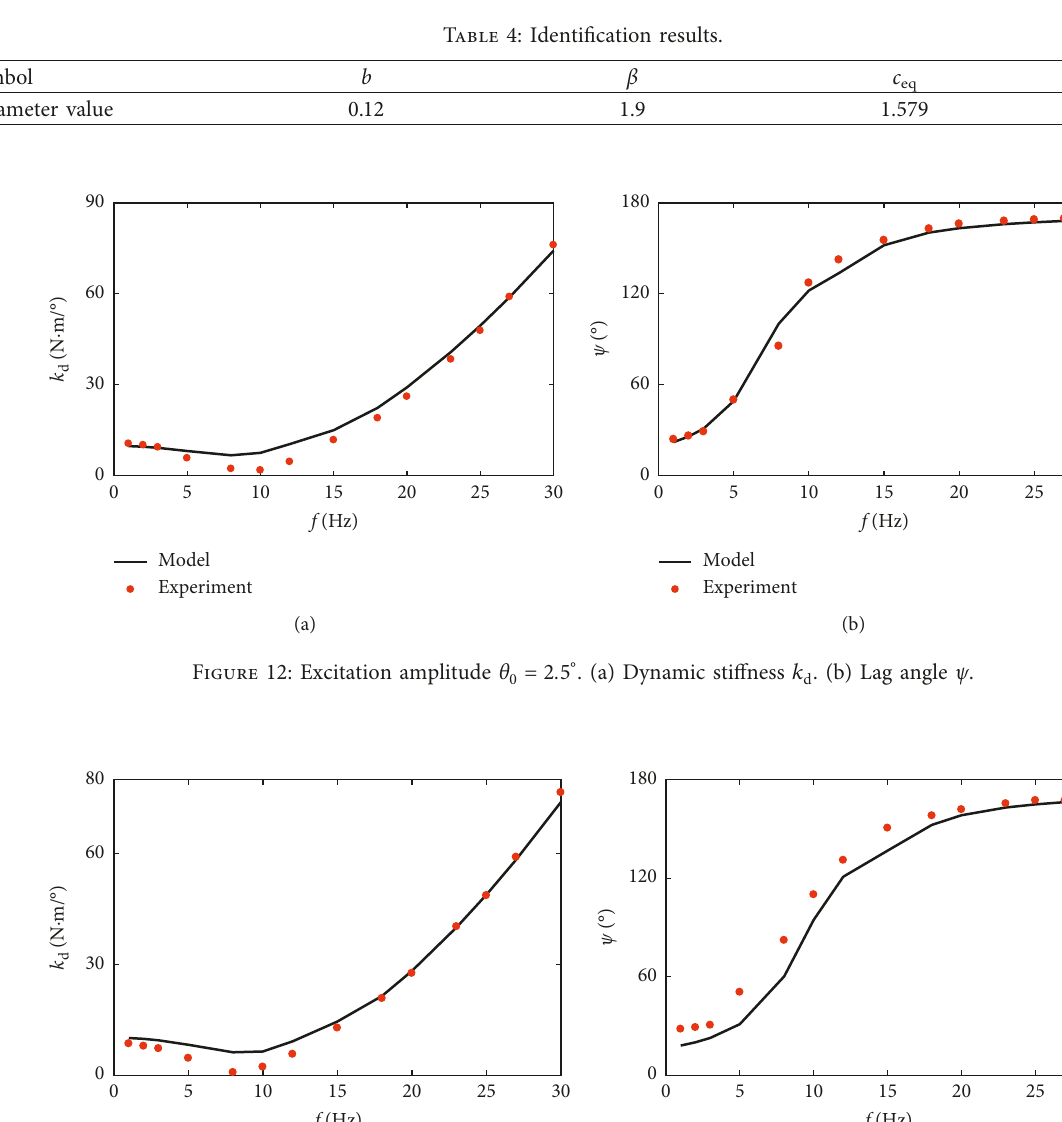
. 5 ° . (a) Dynamic stiffness k 0 (cid:31) 3